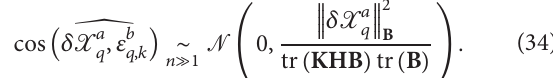
Figure 10. On all these panels, the + symbol denotes the background X 𝑏 𝑞 and × symbol denotes the average position of the analysis state X 𝑎 𝑞 (the average value of | X 𝑎 𝑞 − X 𝑏 𝑞 | is √ tr ( KHB ) ). The hypersphere representing the typical posi- tion of samples of the background distribution N ( X 𝑏 𝑞 , B 𝑞 ) is the circle centered in X 𝑏 𝑞 and of radius √ tr ( B 𝑞 ) , denoted by C 1 = C ( X 𝑏 𝑞 , √ tr ( B 𝑞 )) . The typical position of samples of the analysis distribution N ( X 𝑎 𝑞 , A 𝑞 ) is the circle with triangle centered in X 𝑎 𝑞 and of radius √ tr ( A 𝑞 ) , denoted by = C ( X 𝑎 , √ tr ( A )) . The circle with diamond represents C 2 𝑞 𝑞 the hypersphere, C 3 = C ( X 𝑎 𝑞 , √ tr [( I + K 𝑞 H 𝑞 ) B 𝑞 ]) , that of | X 𝑎 𝑞 − X 𝑏 𝑞,𝑘 | . Since X 𝑏 𝑞,𝑘 should be typical of C 1 and C 2